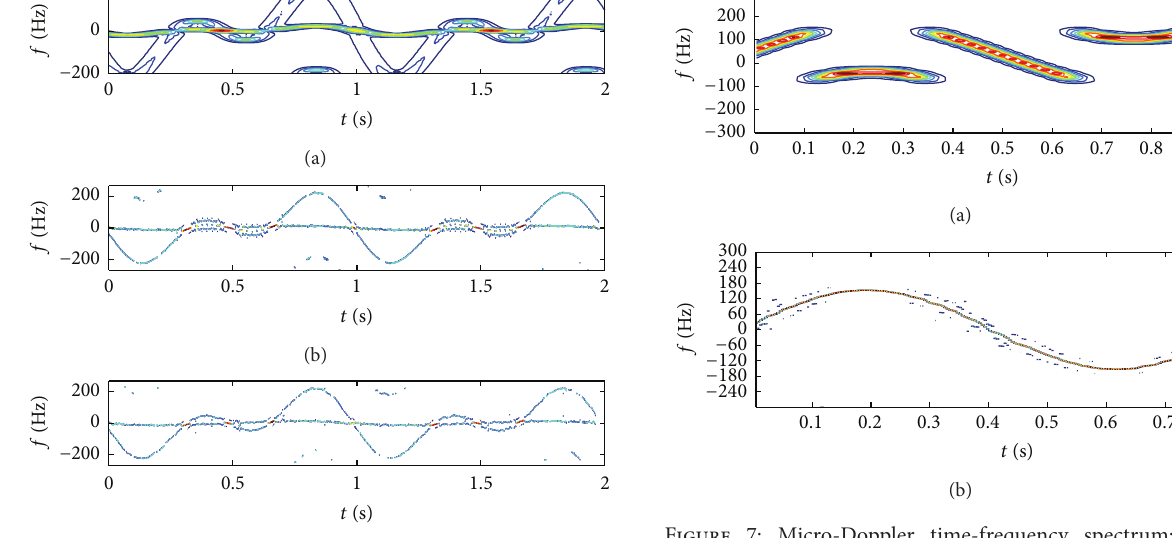
Figure 7: Micro-Doppler time-frequency spectrum: ambigu- ous time-frequency spectrum via STFT (a); unambiguous time- frequency spectrum of adding-perturbation sparse-PRF via CS